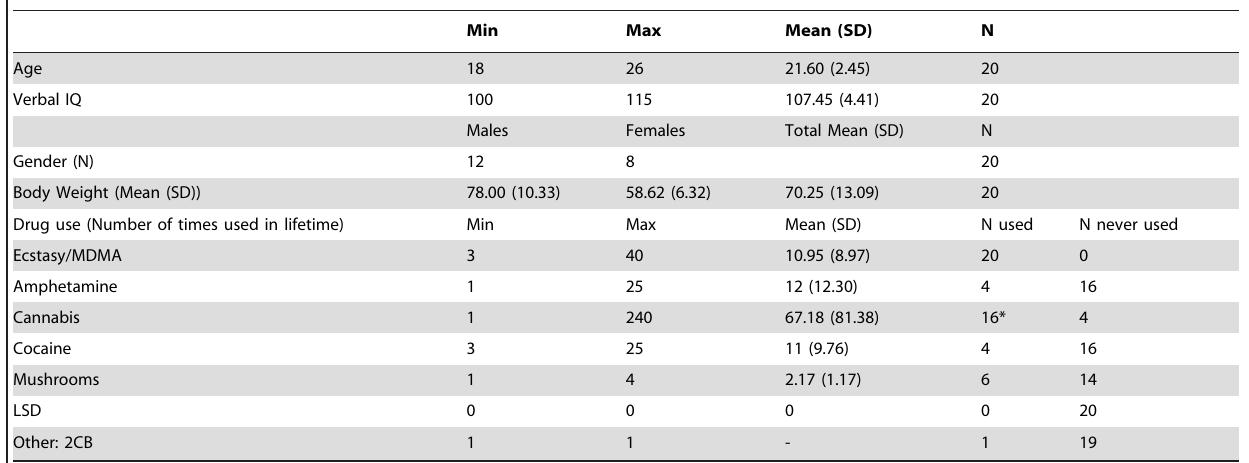
Table 1. Demographic data of participants.